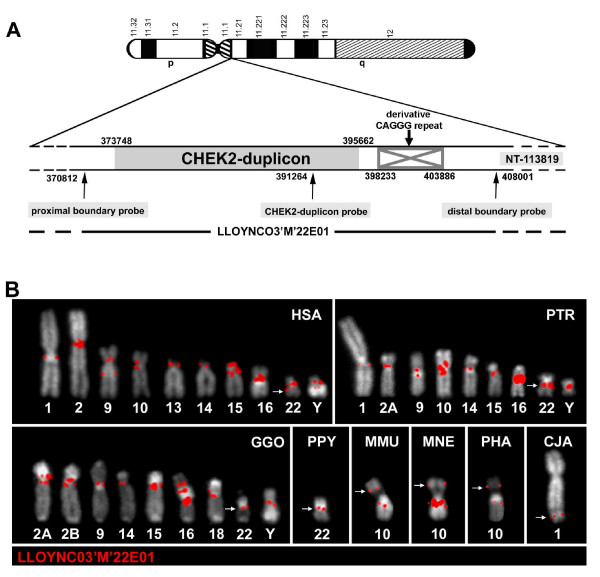
FISH with a CHEK2 duplicon containing Y-chromosomal cosmid probe in anthropoids. (A): Schematic representation of the human Y chromosome with an enlarged view of the CHEK2 duplicon in Yq11.1/Yq11.21. Basepair positions within the Y-chromosomal contig NT_113819 are indicated for the CHEK2 duplicon boundaries, for all probes used to identify a CHEK2 duplicon containing cosmid and for the derivative CAGGG repeat sequences. Localization of FISH probe LLOYNC03'M'22E01 within the Y-chromosomal contig is shown below. (B) Comparative FISH of cosmid LLOYNC03'M'22E01 (labelled in red) covering the human Y-chromosomal derivative CHEK2 duplicon in Yq11.1/Yq11.21 on human (HSA), chimpanzee (PTR), gorilla (GGO), orangutan (PPY), rhesus macaque (MMU), pig-tailed macaque (MNE), baboon (PHA) and marmoset (CJA) metaphase chromosomes. The great ape chromosomal designations are given according to [65], for MMU, MNE and PHA according to [47] and for CJA according to [66]. White arrows indicate the ancestral CHEK2 locus.